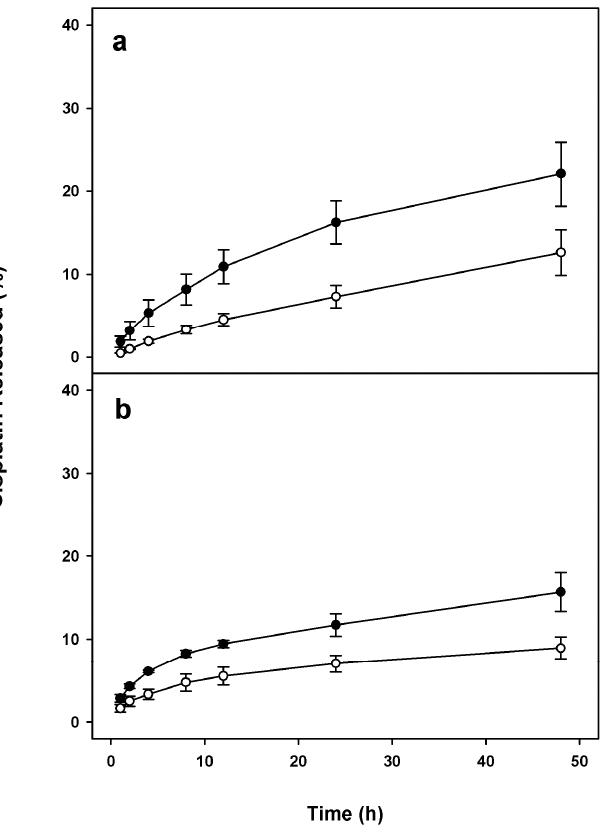
Figure 5. In vitro drug release profiles of cisplatin-loaded liposomes (Cis-Ls, white dots) and cisplatin-loaded magnetic liposomes (Cis-MLs, black dots). ( a ) Percentage of cisplatin released after 48 h of incubation at room temperature in saline solution. ( b ) Percentage of cisplatin released after 48 h of incubation at 37 °C in human serum. Values are expressed as the mean ± SEM ( n = 3).